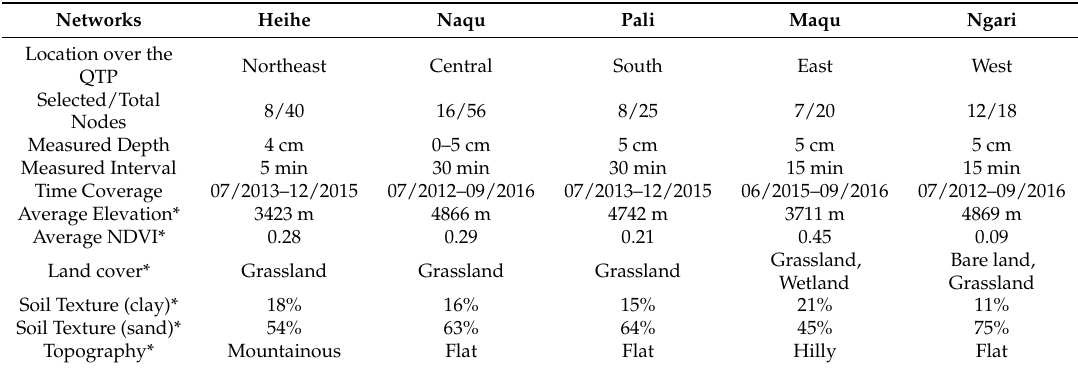
Table 1. Information of the in situ networks.